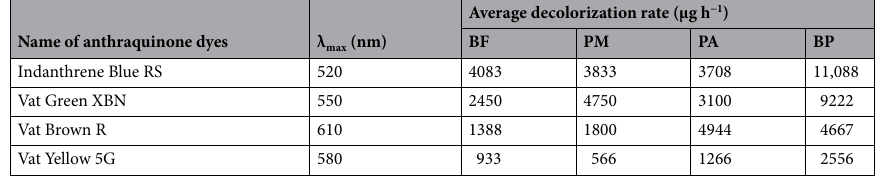
Table 1. Average decolorization rate of individual strains and the consortium-BP of various anthraquinone dyes (100 mg L −1 ). BF Bacillus flexus TS8; PM Proteus mirabilis PMS; PA Pseudomonas aeruginosa NCH; BP developed consortium.